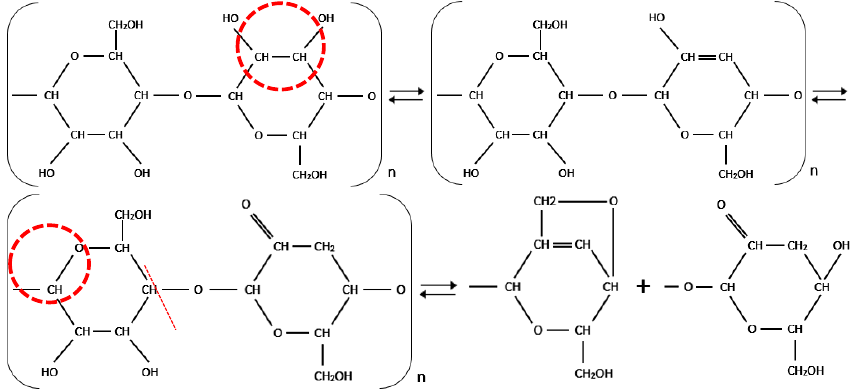
Figure 5. Cleavage of cellulose chains.